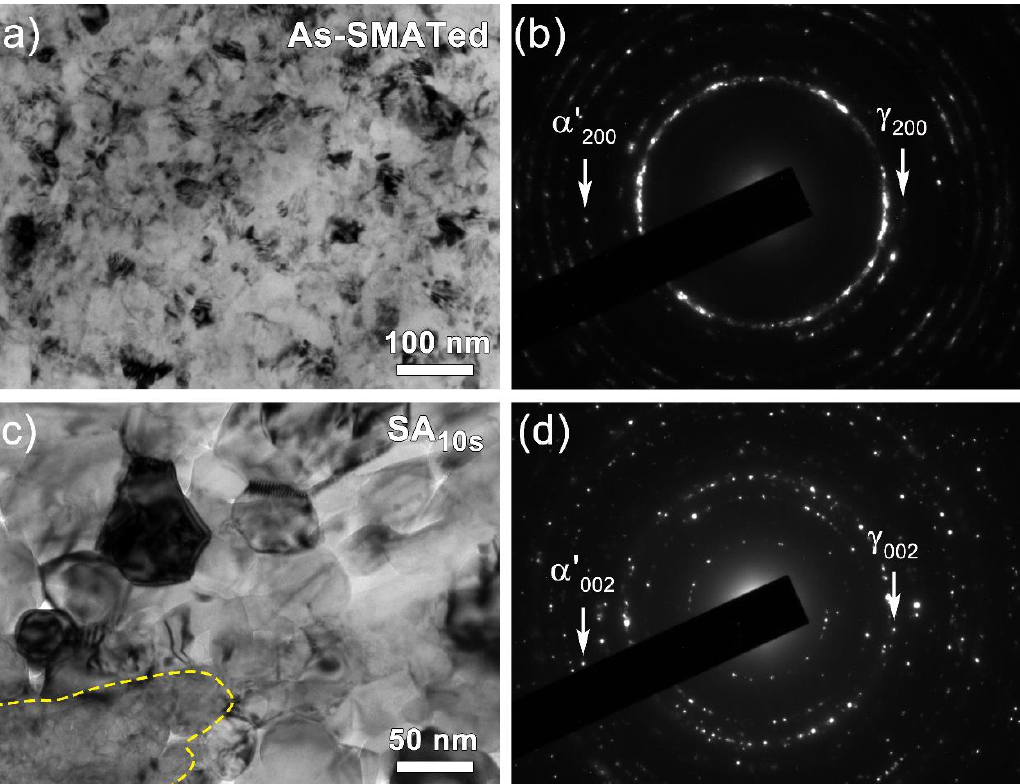
Figure 7. TEM images taken from a depth of ~10 μm in ( a , b ) as-SMATed gradient sample and ( c , d ) SA 10s sample, showing the partial reverse transformation and recrystallized austenitic nano-grains in the latter. Comparing the SAED patterns in ( b , d ) suggests dramatic enhancement of austenitic spots after annealing.